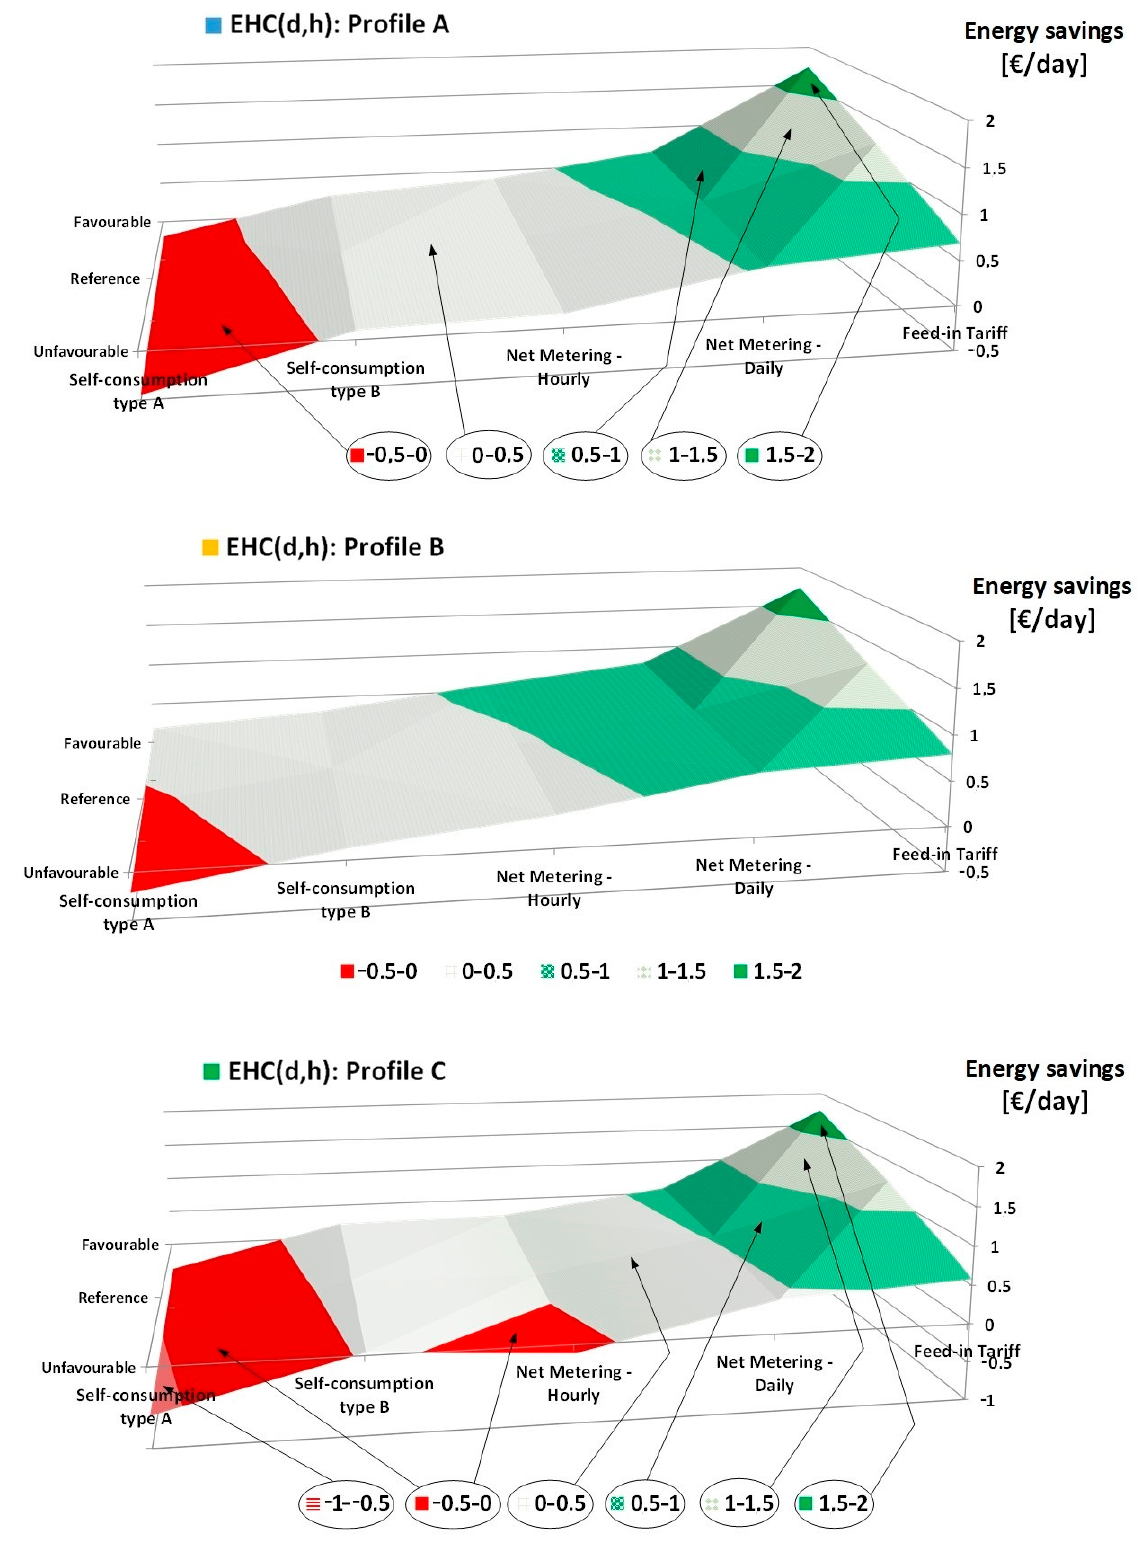
Figure 13. Energy economic results of a single prosumer without ESS under different types of consumption profiles. Source: self-elaboration.